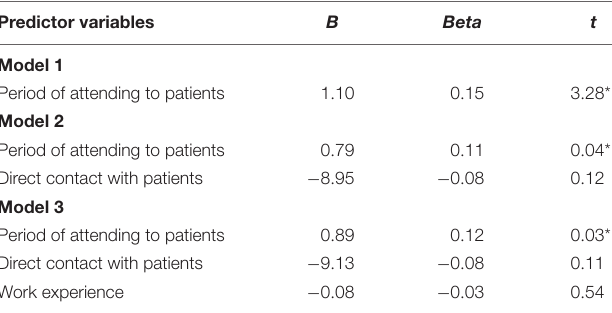
TABLE 3 | Hierarchical regression results for predictors of experience, direct contact with COVID-19 patients, and period spend attending to COVID-19 patients.